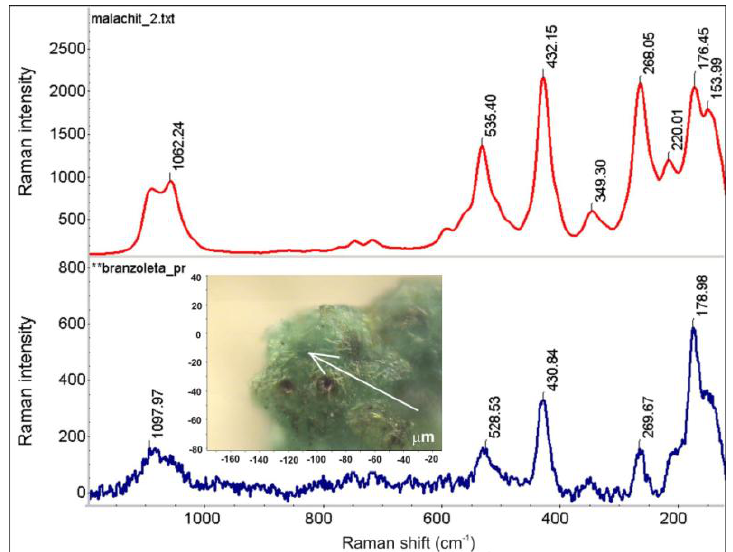
Figure 25. Comparison of the Raman spectrum of malachite Cu with the Raman spectrum of the green corrosion spot (lower plot) indicated on the small micro-photograph (in the